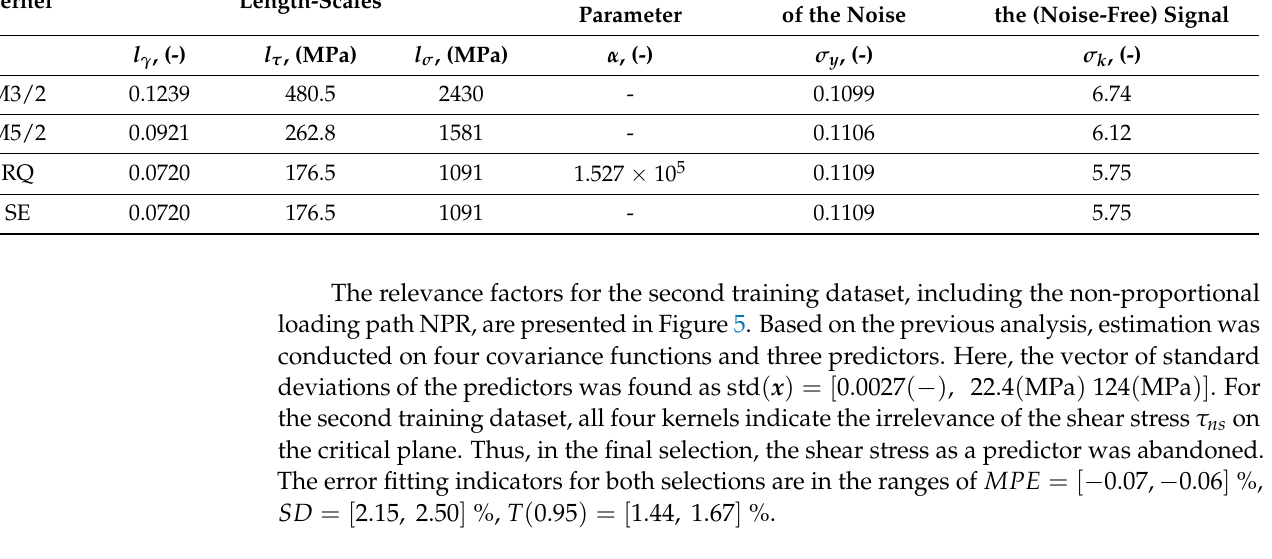
Figure 5. RFs obtained by application of different kernels for the second training dataset (uniaxial, torsion, and NPR path). Table 4. Hyperparameters of the covariance functions for the second training dataset. Kernel